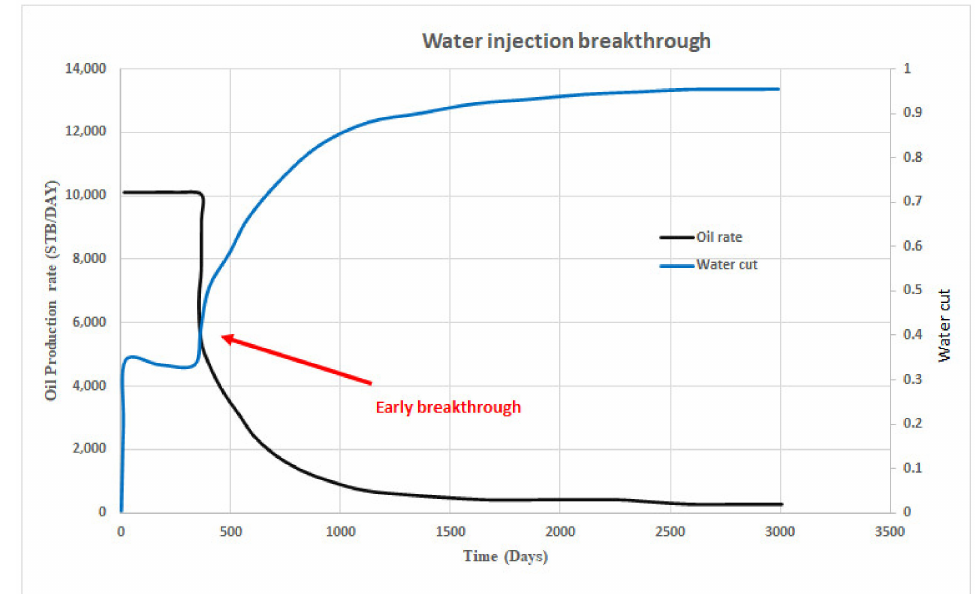
Figure 5. Oil production rate versus water cut for water injection.